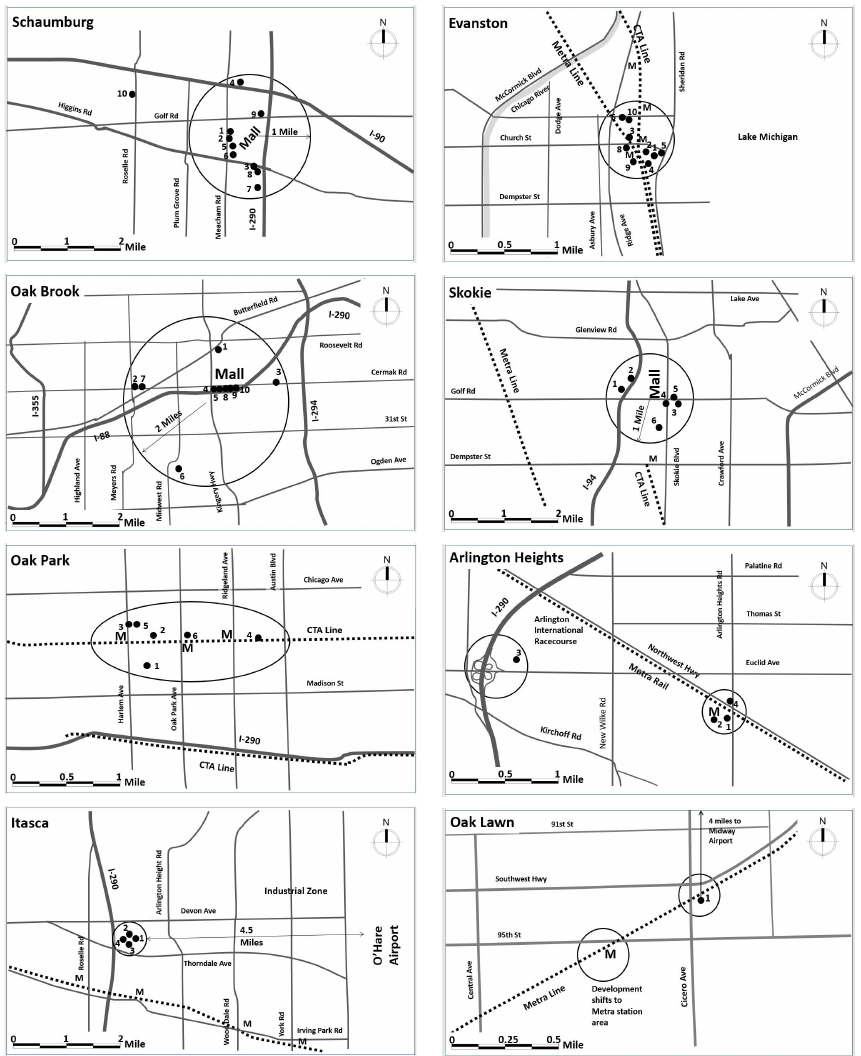
Figure 6. Spatial patterns of tall buildings in suburban communities of Miami Metropolitan Area. Each map shows the locations of the ten tallest buildings in its respective